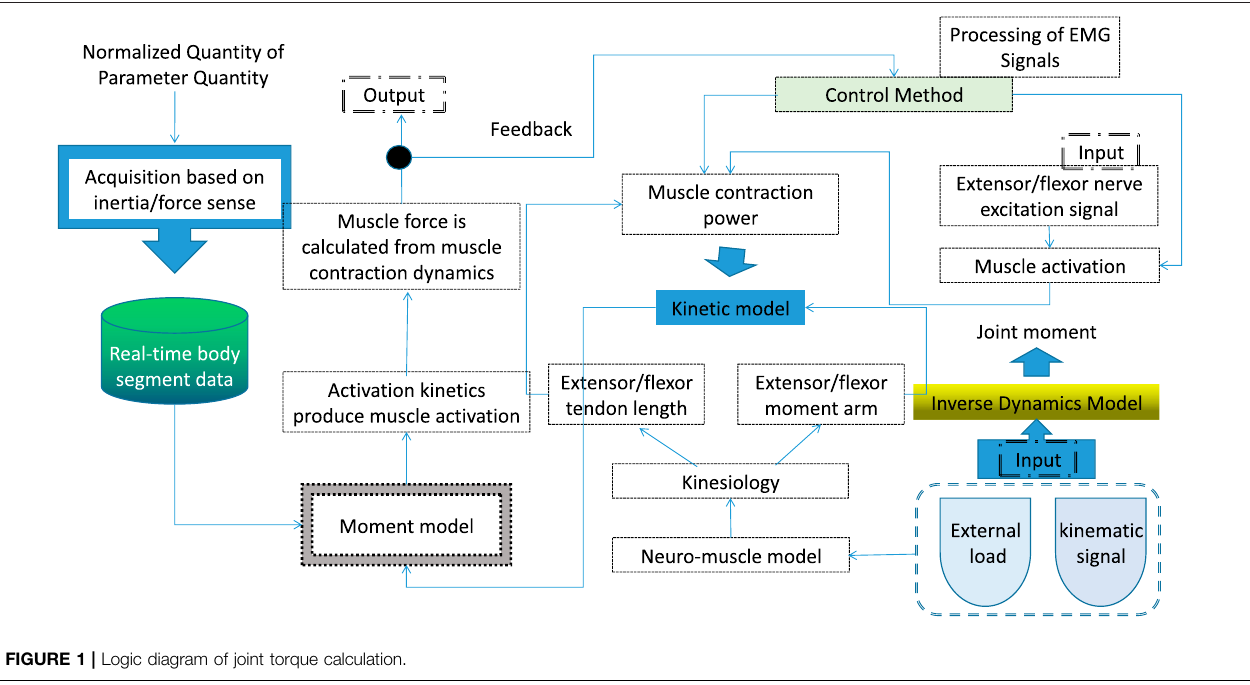
FIGURE 1 | Logic diagram of joint torque calculation.